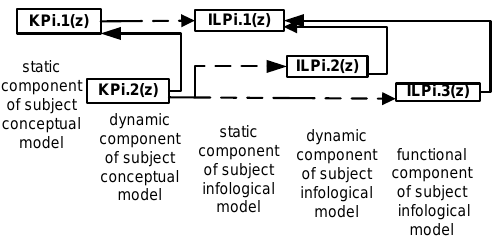
Fig. 1. The general structure of mapping a model of any level